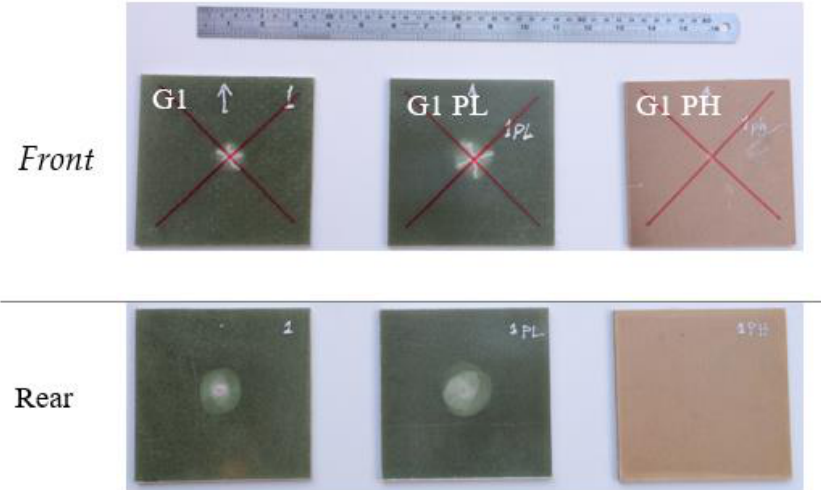
Figure 10. Glass-fiber plates with different resins.